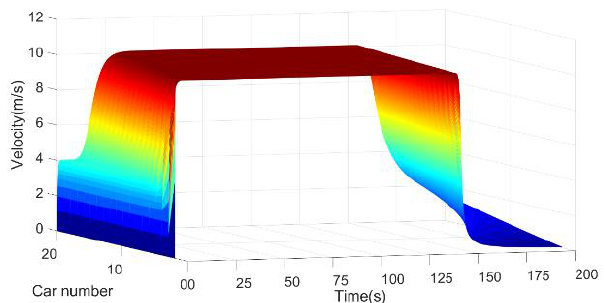
Figure 5. Vehicle velocities in driving situation 3.